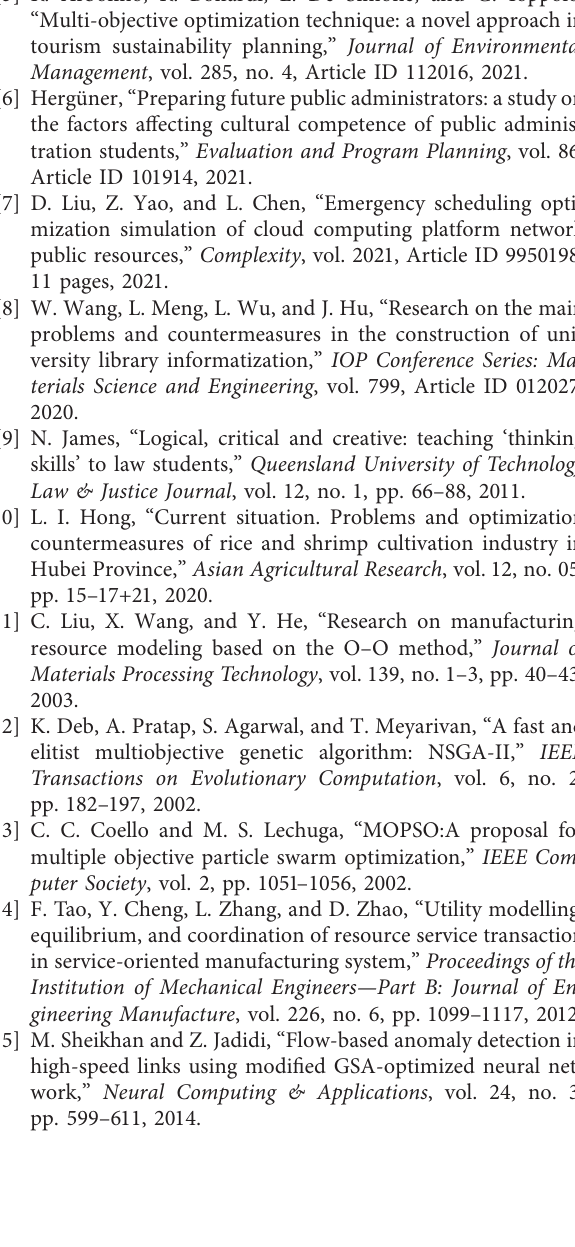
Table 6: Comprehensive resource demand intensity of each task. Task number